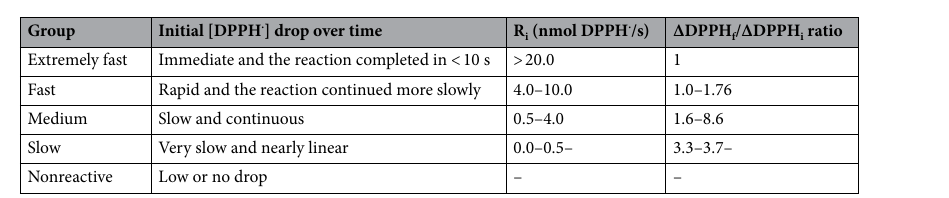
Table 3. The different reactivity patterns of antioxidants in scavenging DPPH · plus the corresponding ranges of their initial reaction rate and the steric accessibility criterion 22